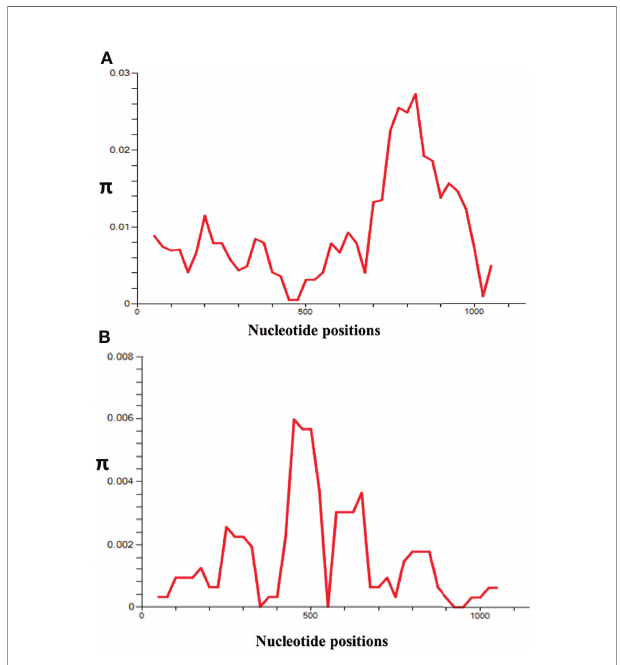
FIGURE 2 | l (A) Graphical representation of nucleotide diversity ( p ) within the PkRhopH2 gene showing high diversity in the region from 700 to 900 nt. (B) Graphical representation of nucleotide diversity ( p ) within the PvRhopH2 gene showing high diversity in the region from 400 to 550 nt. The window length and step size of the p graph are 100 and 25, respectively, as implemented in DnaSP software v5.0.